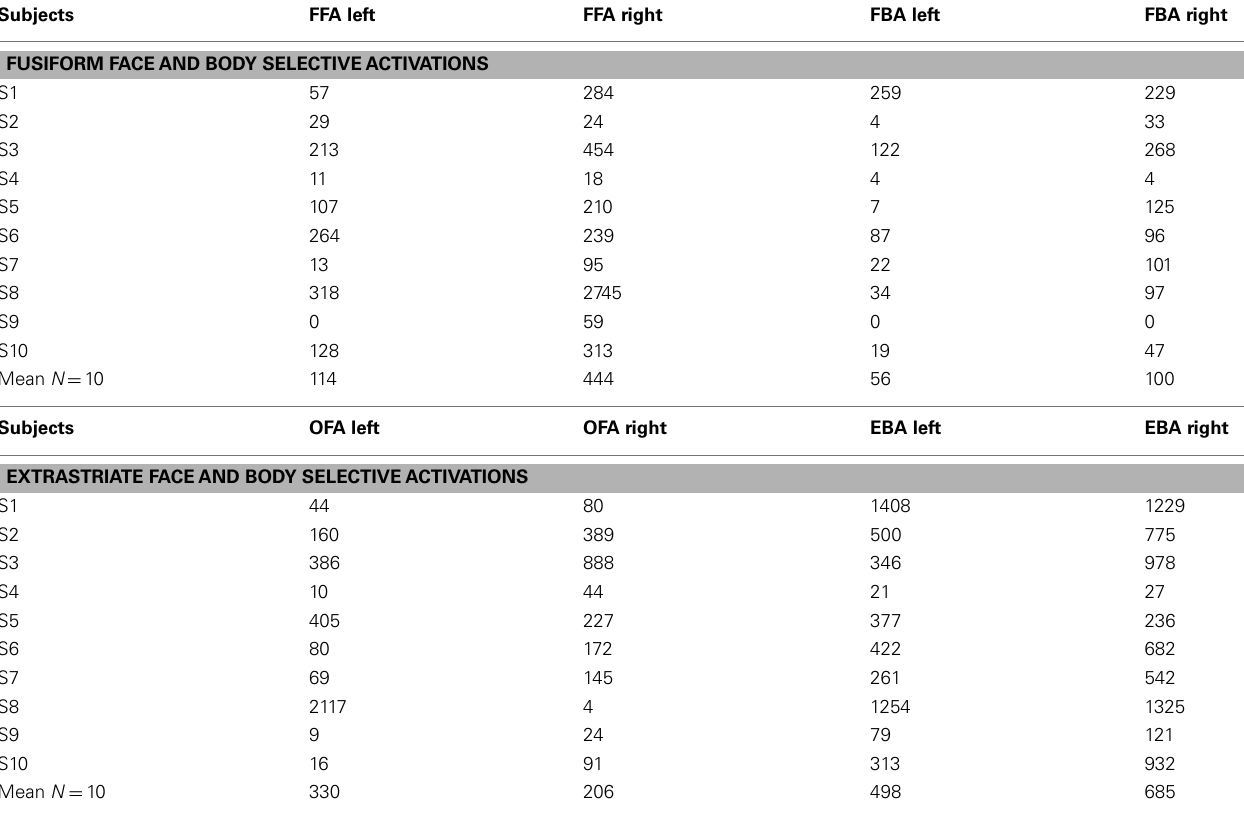
TableA1 | Face and body selective activations shown with the independent localizer: Individual data. Subjects FFA left FFA right FBA left FBA